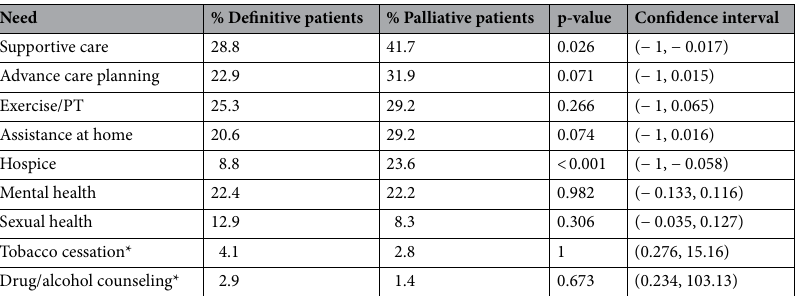
Table 3. Summary of patient needs. The number of patients asking for information about tobacco cessation and drug/alcohol counseling is very small in both groups, which limits statistical testing. *There were very few patients in each group requesting information on tobacco cessation and drug/alcoholcounseling resources, limiting the validity of statistical testing in this population.